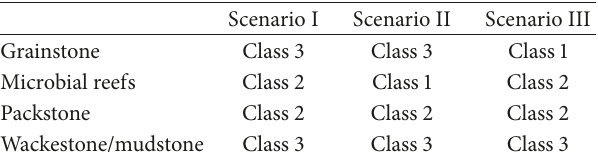
Table 1: Assignment of permeability class and scenario for dolomite rocks used in